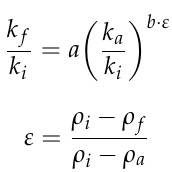
Figure 2. Illustration of frost morphology with the dimensionless temperature of the vertical axis.